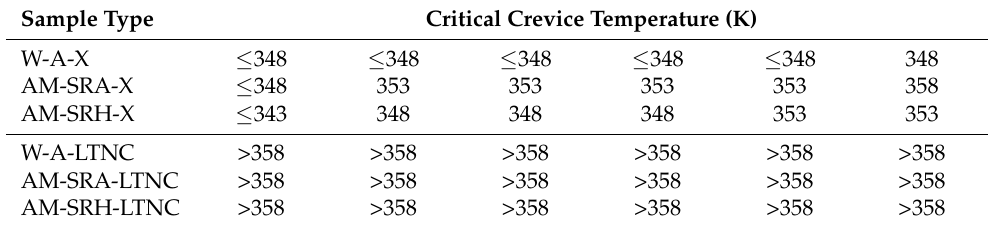
Table 3. Critical Crevice-Corrosion Temperature Testing Results for Alloy